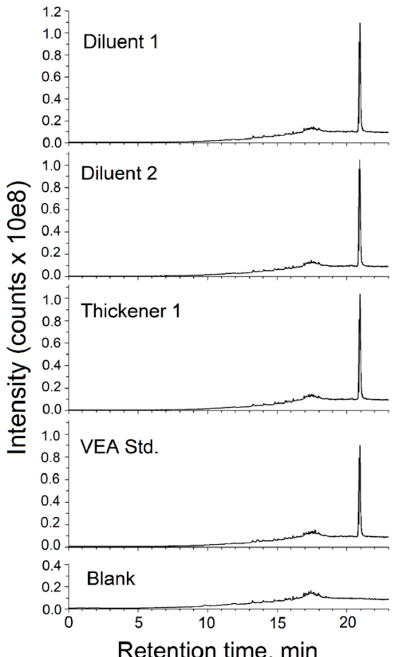
Figure 4. Analysis of commercial cannabis oil additives using LC-HRMS / MS. The TIC chromatograms from the analysis of diluents 1 and 2 and thickener 1 are shown together with that of the VEA standard recorded on the LC-tripleTOF system under the identical analytical